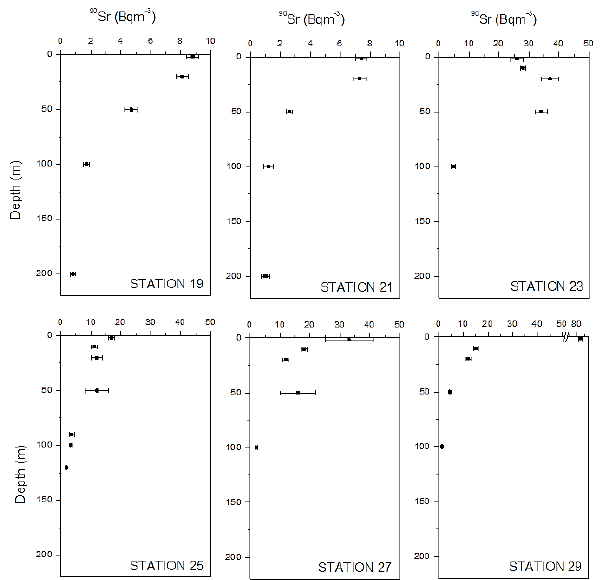
Fig. 3. Specific activities of 90 Sr in shallow profiles at the 6 closest stations of Fukushima Dai-ichi NPP. Note the different scales on the